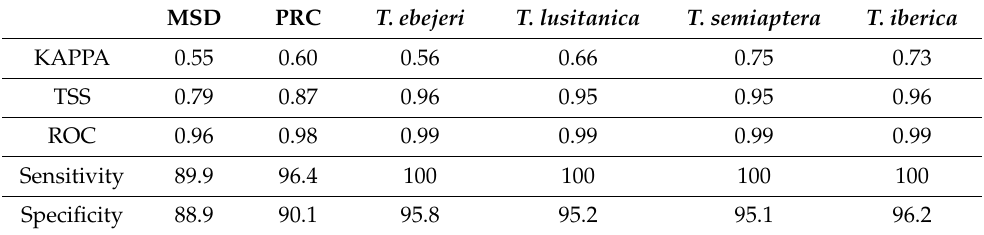
Table 3. Ensemble model evaluation by Cohen’s Kappa, TSS and ROC model performance measures. MSD stands for merged species records and PRC for phylogenetically most related cluster. Sensitivity and Specificity are defined for the cut-off maximizing the TSS value (usually very similar to that of